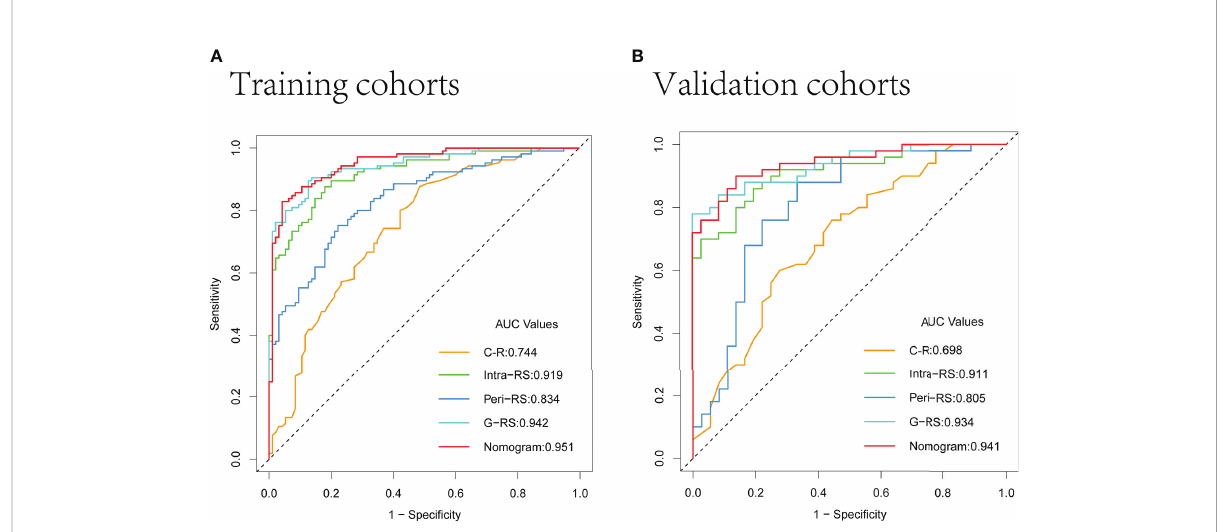
FIGURE 8 ROC curves of the 5 models in the training (A) and validation (B) sets.